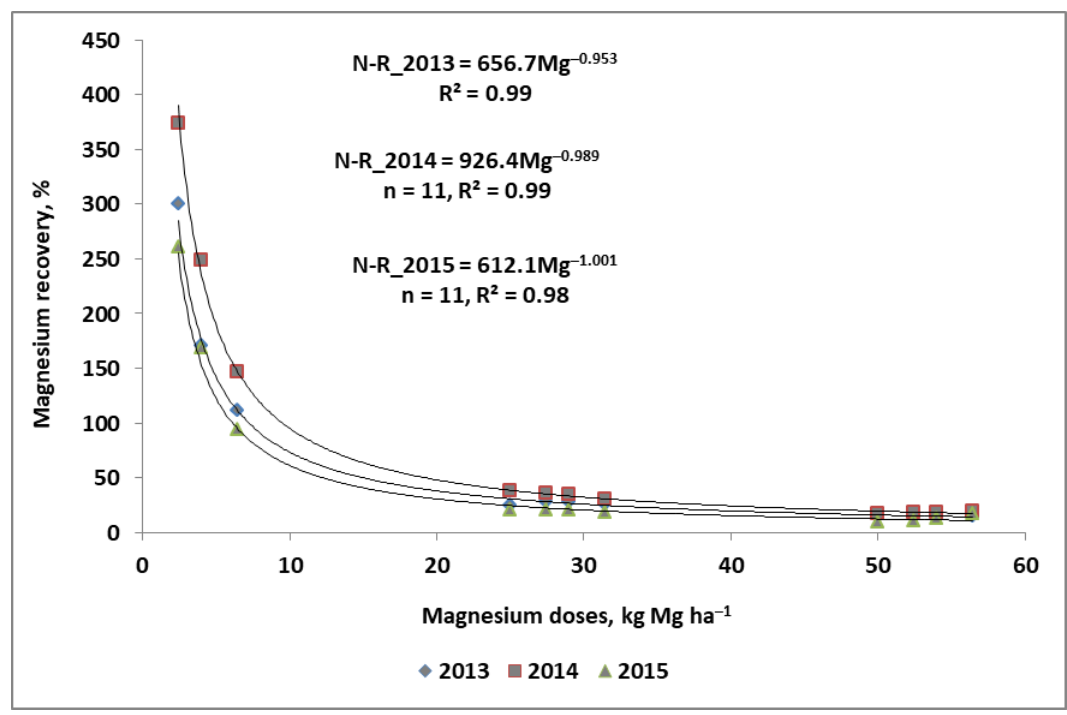
Figure A3. General course of magnesium recovery in consecutive years of study.